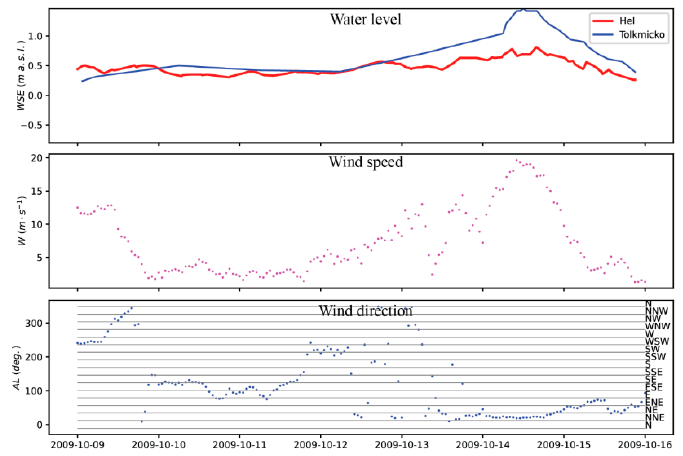
Figure 6. Water level (WSE) variation at Tolkmicko and Hel, wind speed and direction—the case (9–16 October 2009) in which wind originates from a northerly direction for a long period of time causes the water level at Tolkmicko to increase in comparison to the water level at Hel (raw data; measurement frequency of WSE is 10 (min), wind data 1 (h)).